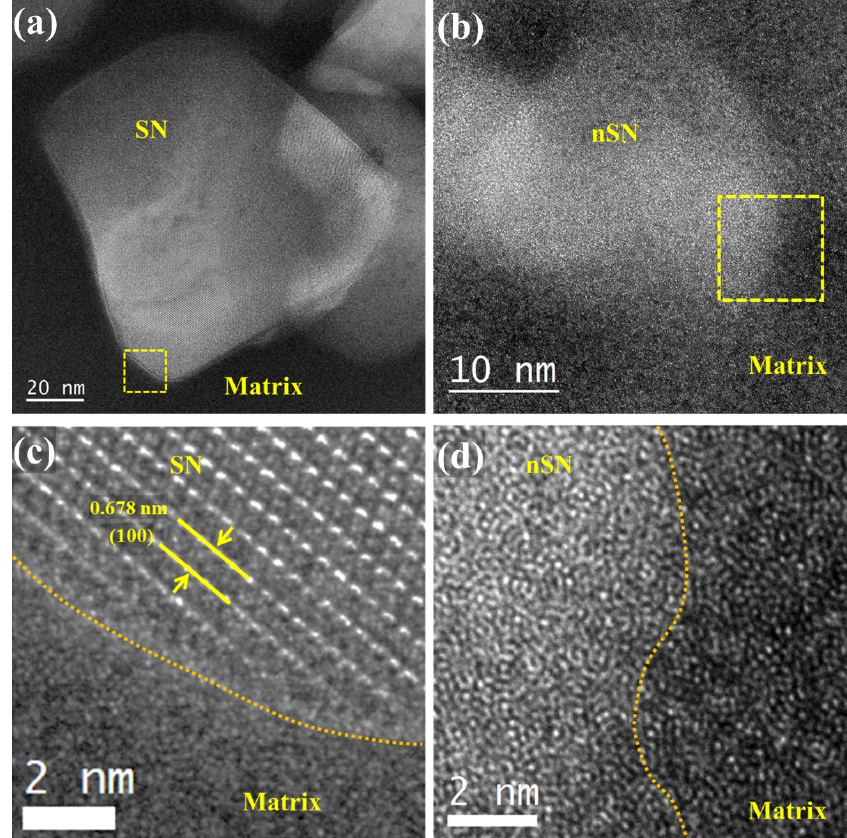
Figure 5. HRTEM images of Si 3 N 4 particles in the Ni-P matrix in the specimens ( a ) Ni-P-SN and ( b ) Ni-P-nSN. The magnified view of the area indicated by a dotted square in ( a , b ) are shown in ( c , d ), respectively. The dotted lines in ( c , d ) are interfaces separating the particle and matrix.